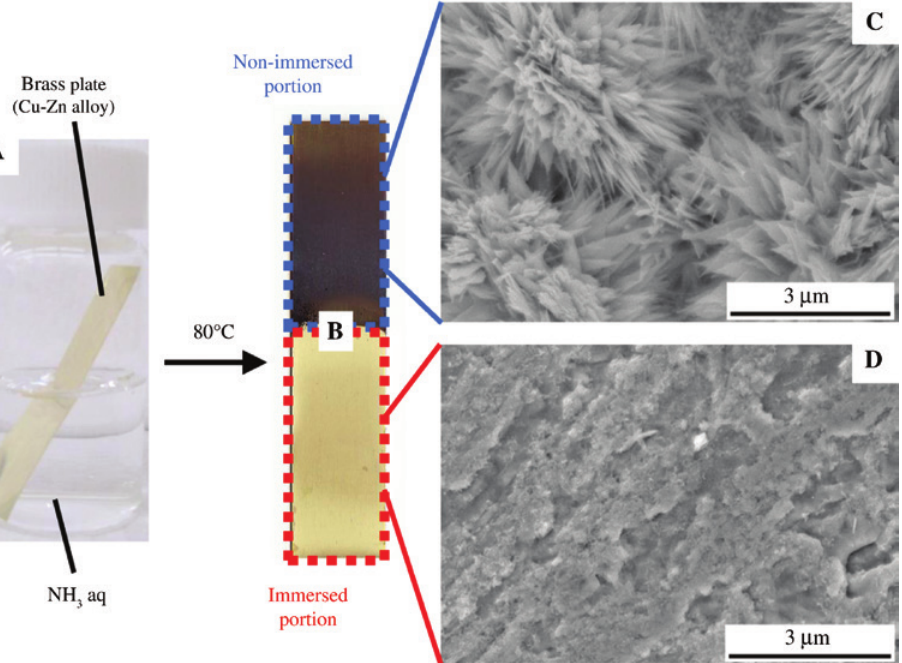
Figure 4: Production of CuO-ZnO nanocomposite by an alkaline vapor oxidation process. SEM images of brass plate at the non-immersed portion (C) and the immersed portion (D) after the reaction. Copyrights reserved to Elsevier